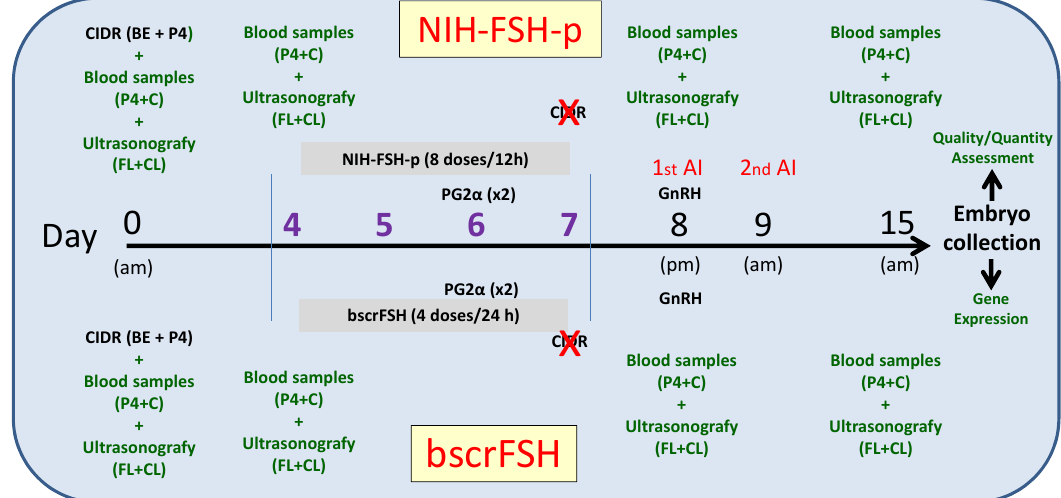
Figure 1. Experimental design including the both superovulation (SOV) protocols (NIH-FSH-p and bscrFSH). NIH-FSH-p: 280 mg (total); 2 applications per day (a.m./p.m.) scheduled at 12 h intervals